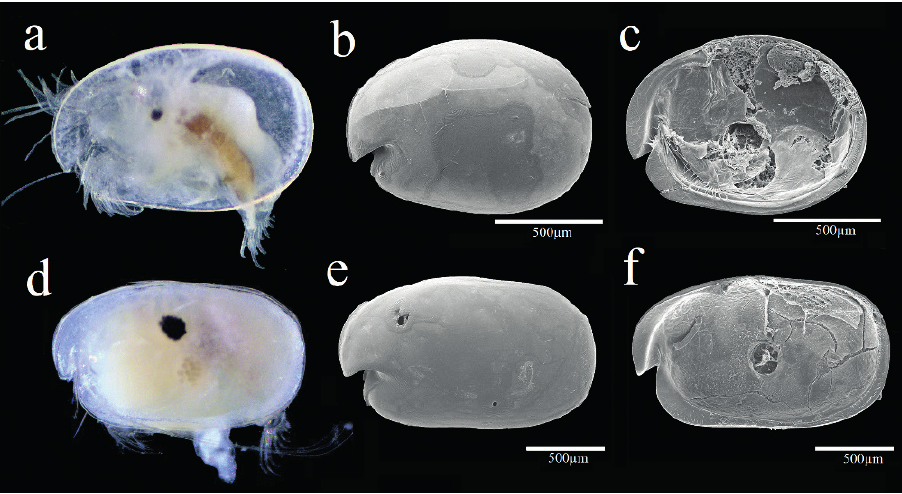
Figure 5. Light microscopy and scanning electron microscopy images of Parasterope sagami sp. nov. a–c holotype female adult: a External view b Lateral view from right valve c Internal view from left valve. d–f paratype male adult: d External view e Lateral view from right valve f Internal view of left